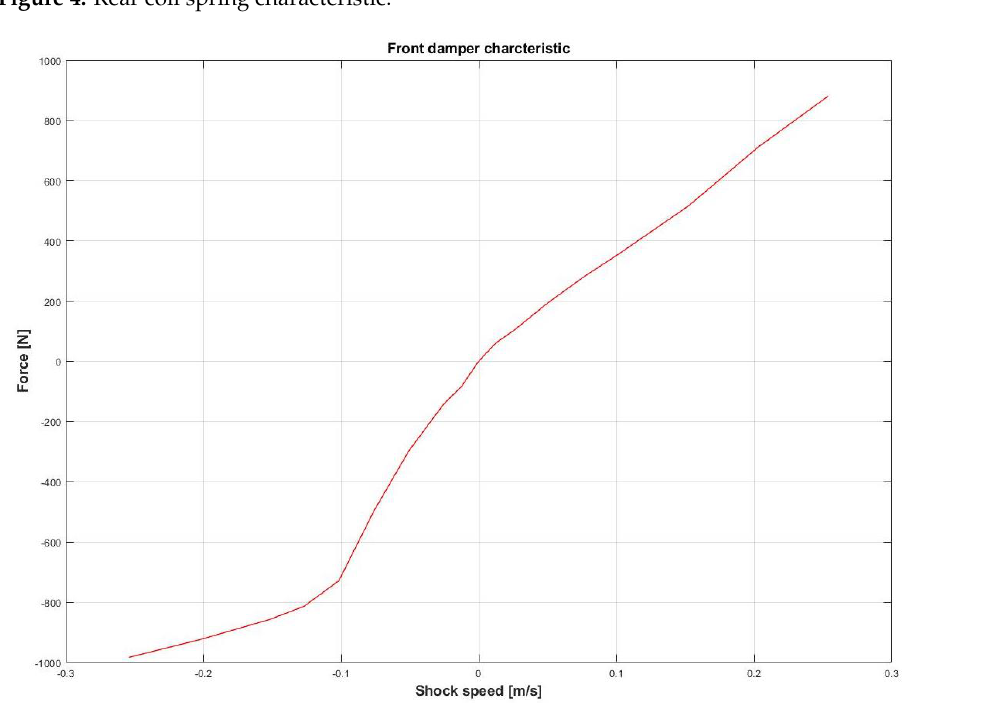
Figure 4. Rear coil spring characteristic.